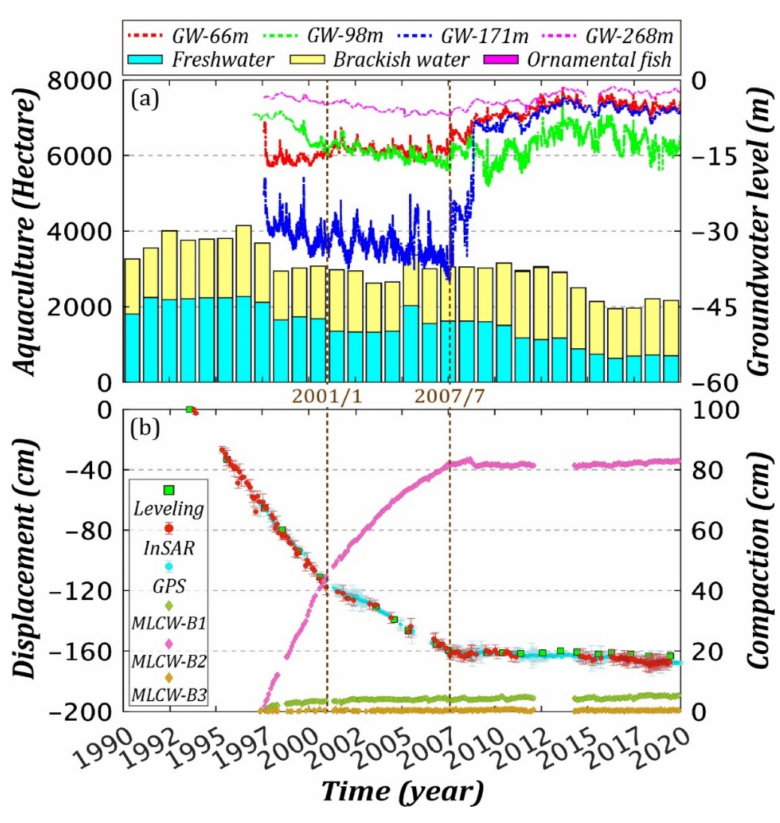
Figure 6. ( a ) The areas of aquaculture fishery in Changhua County from 1990 to 2019. The cyan, light yellow, and pink rectangles show the areas of freshwater aquaculture, brackish aquaculture, and ornamental fish, respectively. The red, green, blue, and pink dash lines indicate the groundwater levels at the depths of 66 m, 98 m, 171 m, and 268 m. The areas of freshwater aquaculture affect groundwater levels in the shallow aquifer. ( b ) Long-term observed land subsidence values from leveling, InSAR, CGPS, and MLCWs in Dacheng Township of Changhua County (green square, red and cyan circles, and green, pink, and amber diamonds) from 1992 to